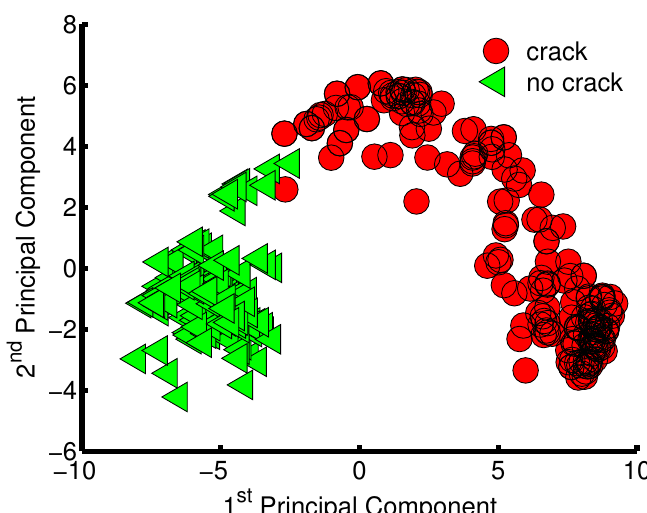
Figure 7. Plot of the first two principal components, which contributed more than 75% of the variance.